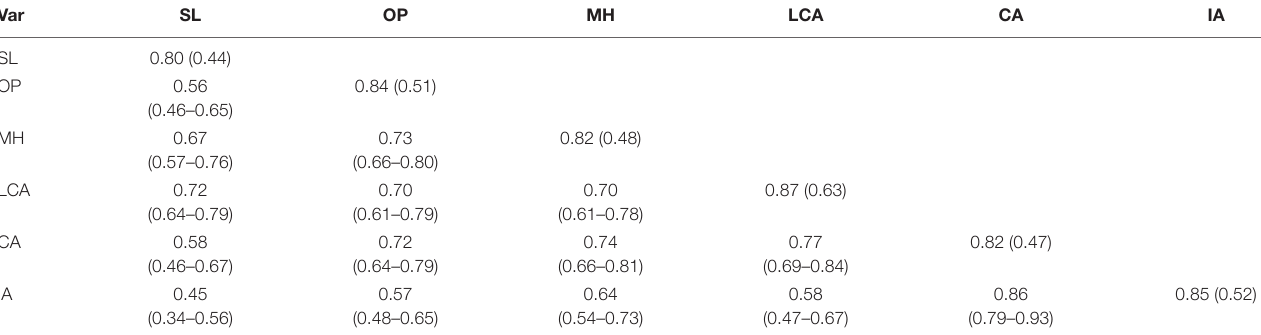
TABLE 4 | CR and AVE pertaining to the measurement model and variable correlation matrix.